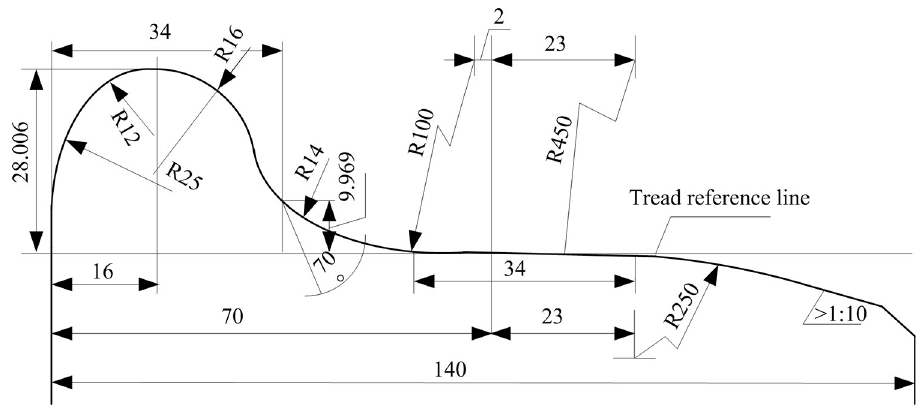
Fig 1. JM3 type tread